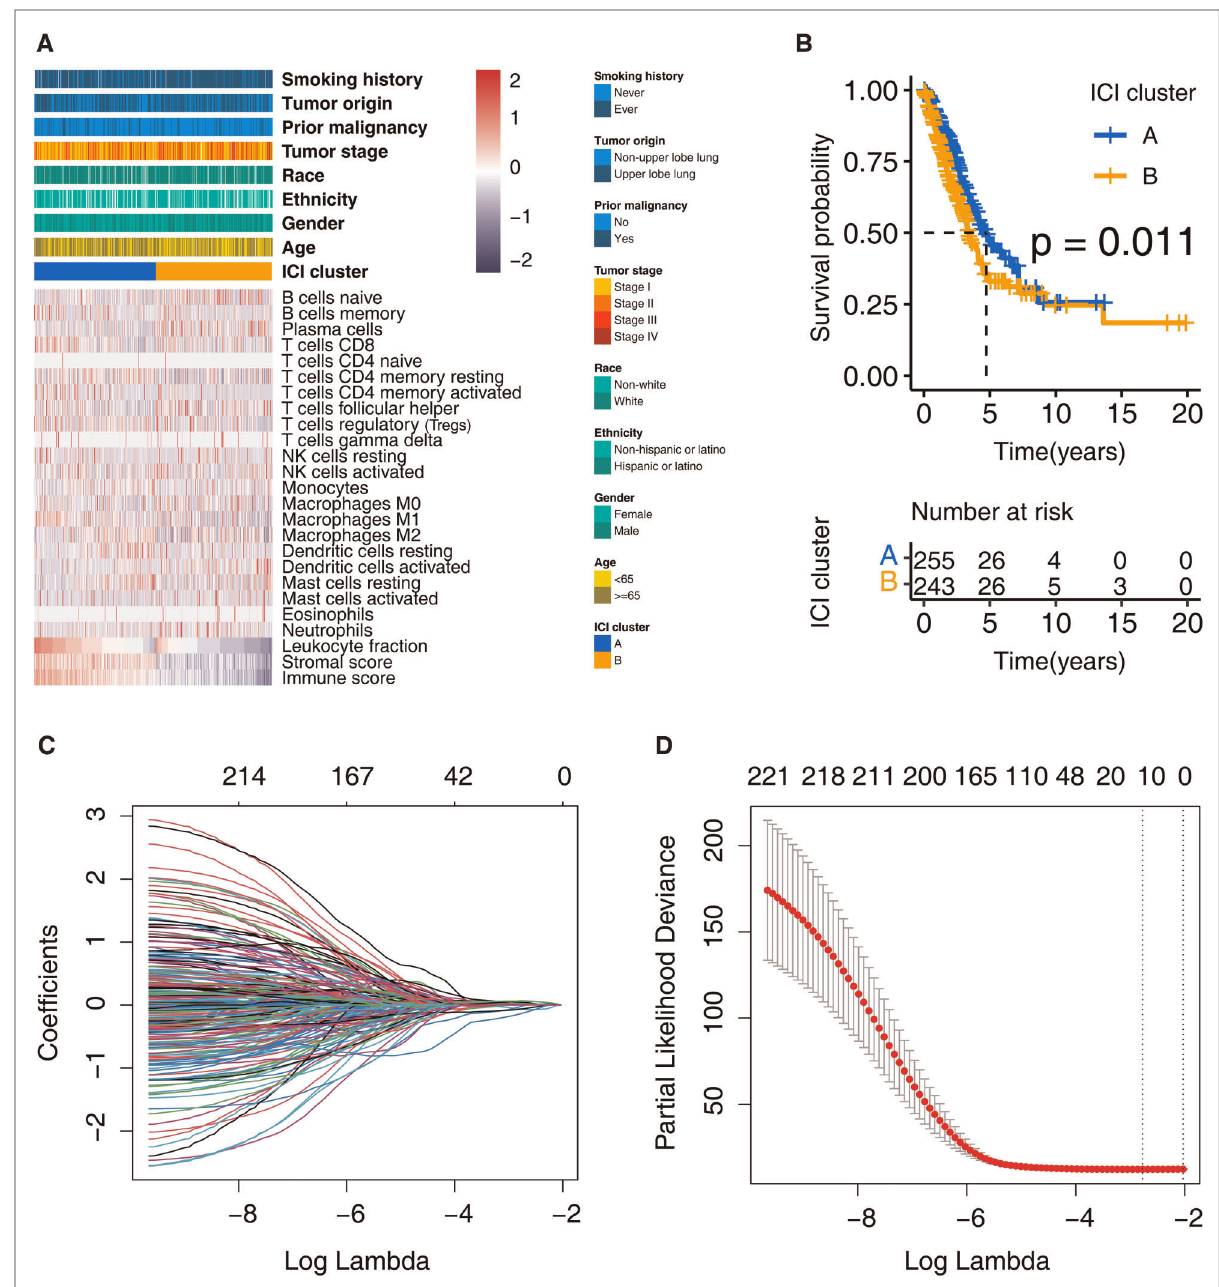
FIGURE 2 Clustering the LUADs based on the pro fi le of ICI and identifying the prognosis signature. ( A ) LUADs in the training cohort were grouped into two clusters. Each row represents one ICI type, and each column indicates one LUAD case. ( B ) Kaplan-Meier analysis shows that the survival of these two clusters is statistically signi fi cant, that is, p =0.011. ( C ) Ten-time cross-validation for tuning parameter selection in the LASSO model. ( D ) Partial likelihood deviation map with Lasso approach. ICI, immune cell in fi ltration; LUAD, lung